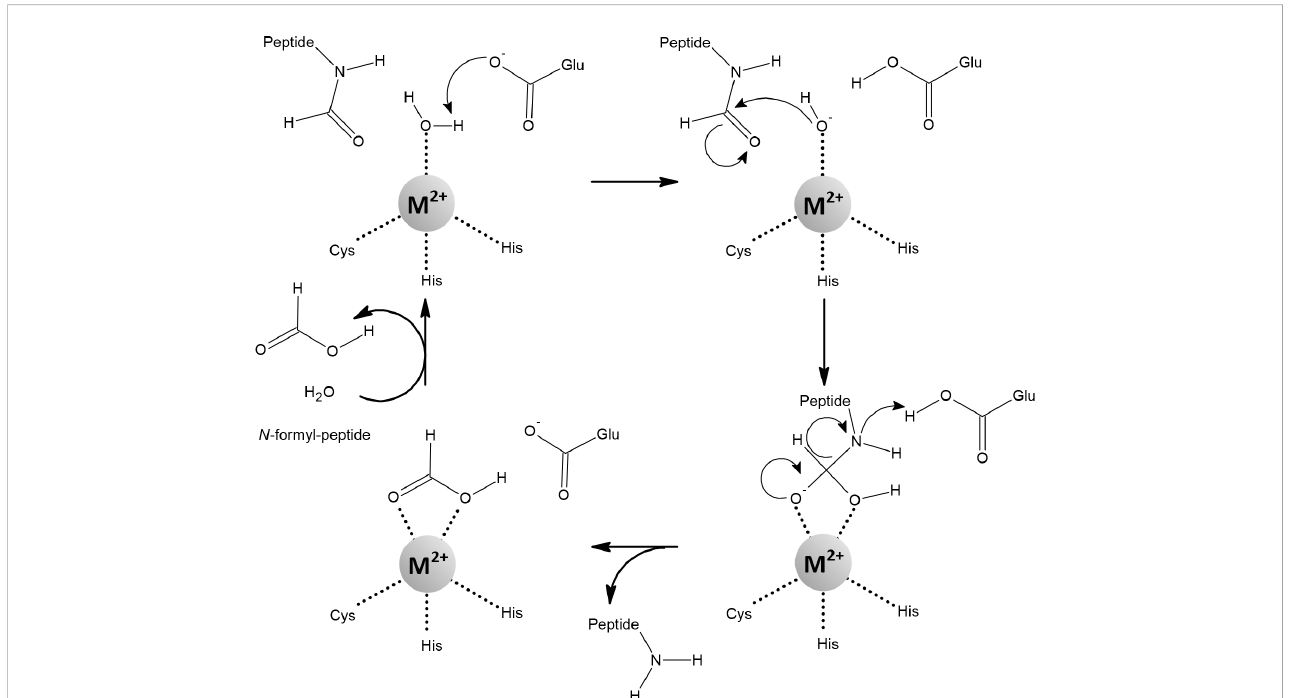
FIGURE 12 The mechanism of the reaction catalyzed by peptide deformylase (PDF). Coordination of the water molecule by the metal ion allows its deprotonation to form hydroxide. The carbon atom of the N -formyl group is subsequently nucleophilically attacked by hydroxide coordinated with the metal. The resulting intermediate is stabilized by a bidentate interaction with the metal ion, which changes its coordination geometry from tetrahedral to fi ve- coordinate. This transition is strongly inhibited when Zn 2+ is bound in the active site. Fe 2+ , Mn 2+ , and Ni 2+ are amenable to a fl exible change in their coordination geometry, which is the normal function of the PDF (Becker et al., 1998; Groche et al., 1998; Wu et al., 2007; Anjem and Imlay, 2012; Fell et al.,